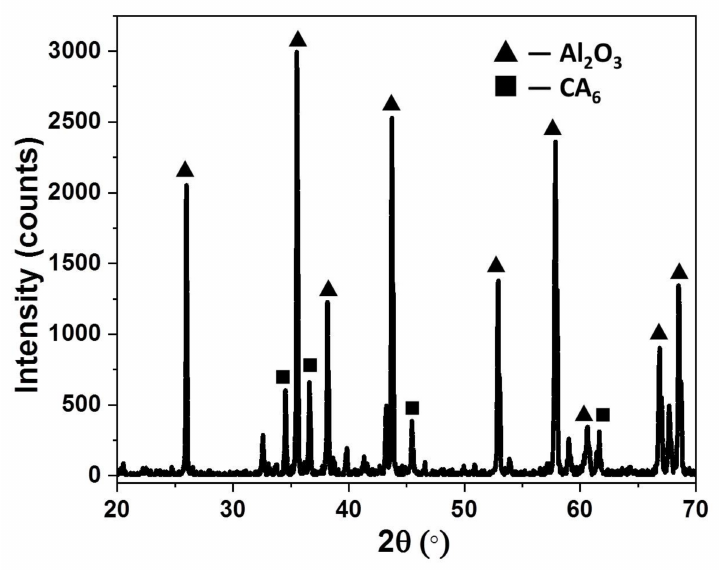
Figure 1. Phase composition of the sintering